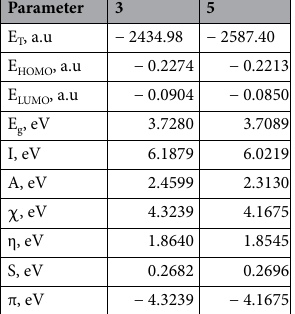
Table 2. Total energy, the energy of HOMO and LUMO, energy gap, ionization energy (I, eV), electron affinity (A, eV), absolute electronegativities, ( χ , eV), absolute hardness (η, eV), global softness (S, eV −1 ) chemical potential (π , eV −1 of 3 and 5 using